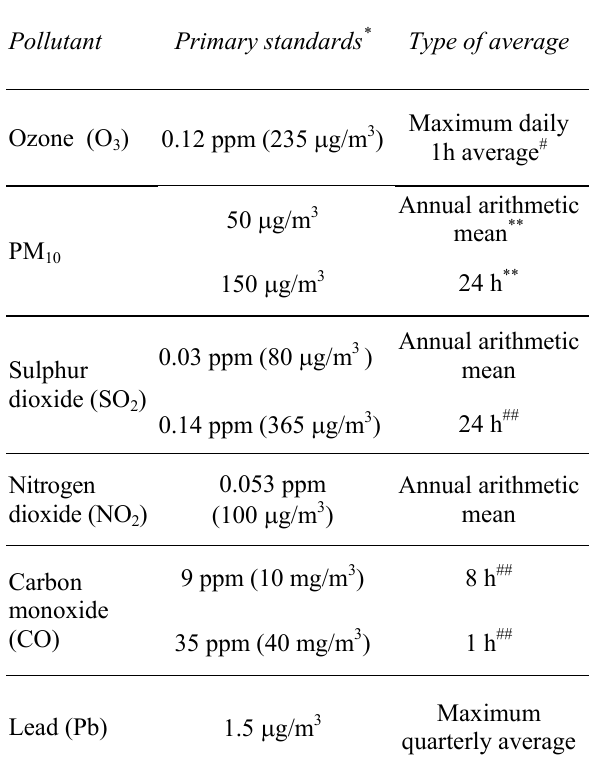
Table 5: National Ambient Air Quality Standards Ref.